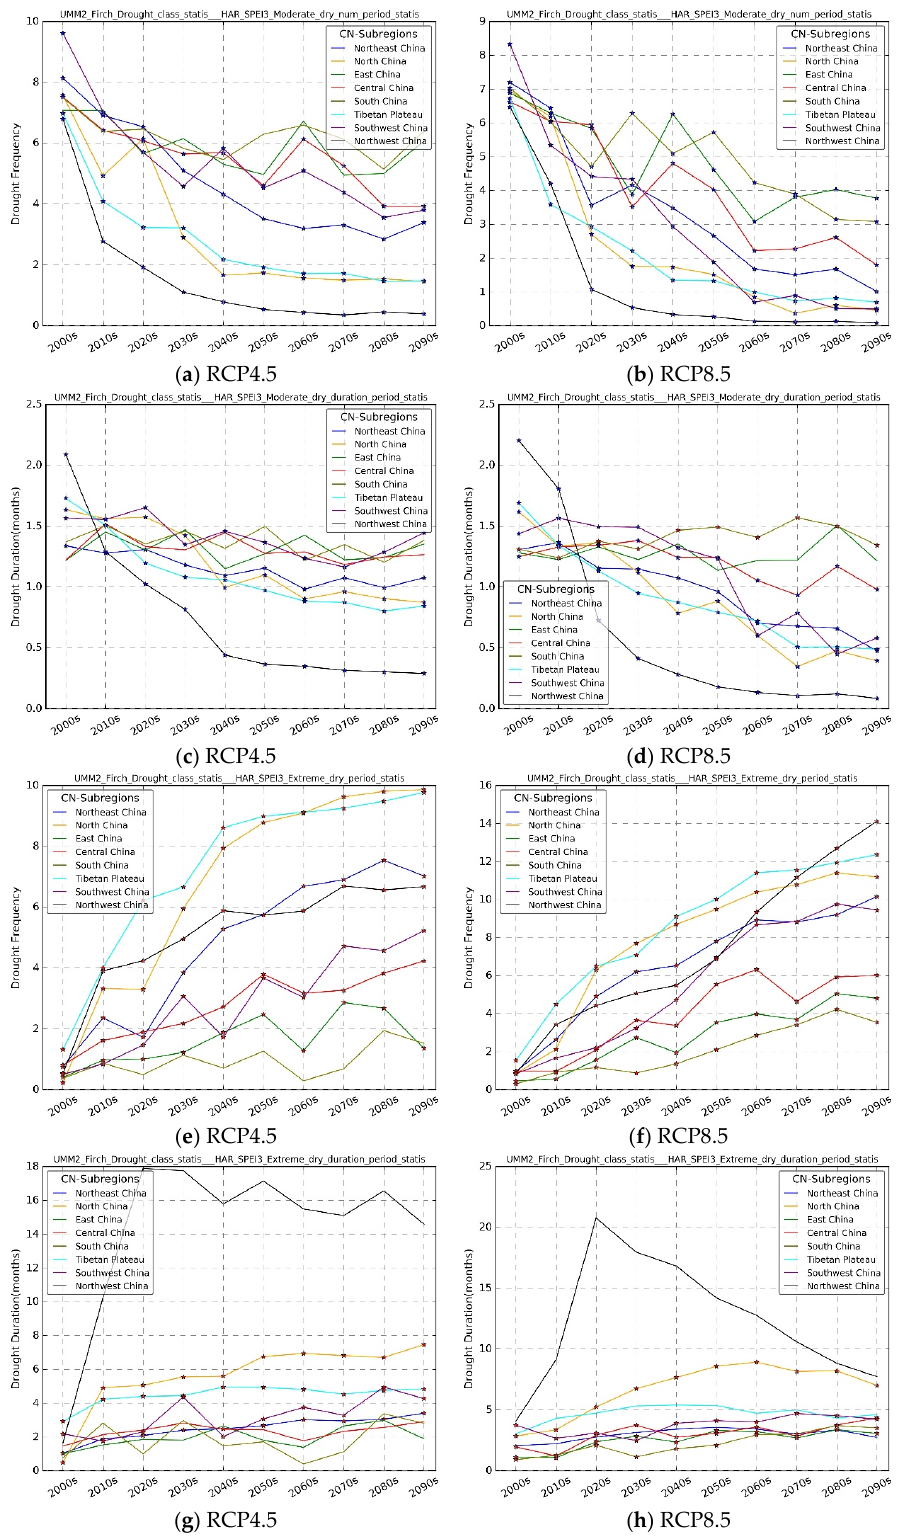
Figure 8. Temporal variation of regional drought frequency—moderate drought: ( a , b ); extreme dry: ( e , f )—and drought duration—moderate drought: ( c , d ); extreme drought: ( g , h )—on the decadal scale under two scenarios over eight climate regions. The red-filled star symbol on the line represents positive trends, while the blue-filled star symbol represents negative